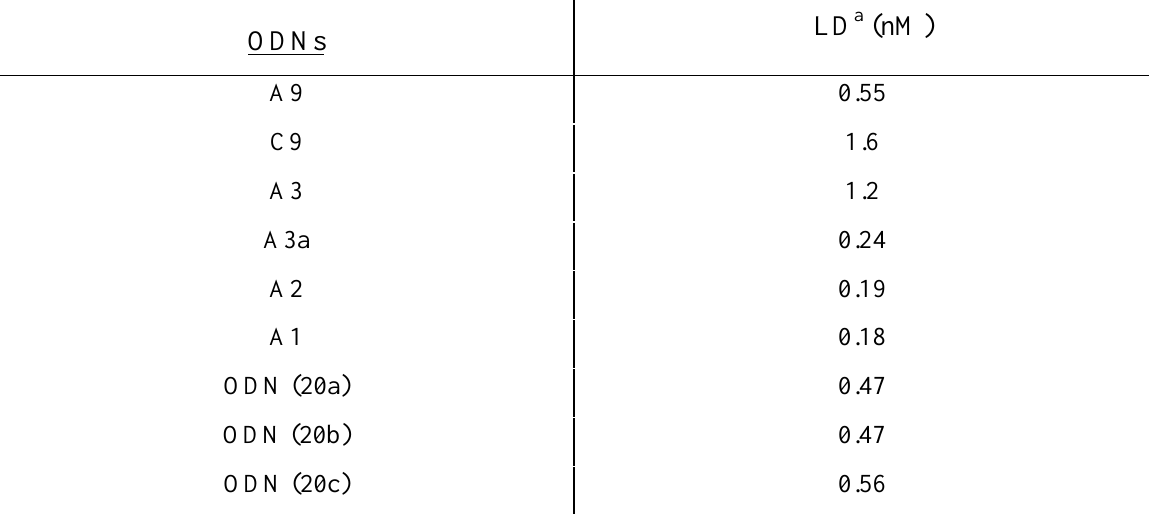
Table 2 . EVLS detection limits of